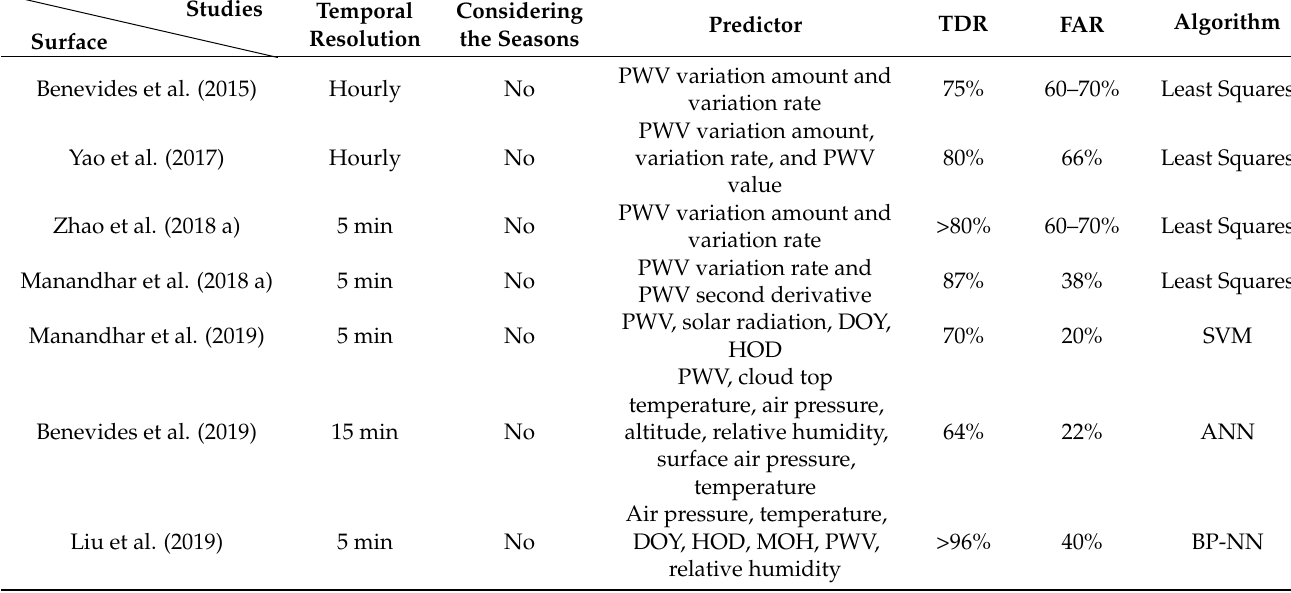
Table 7. Statistics on the accuracy of existing rainfall prediction